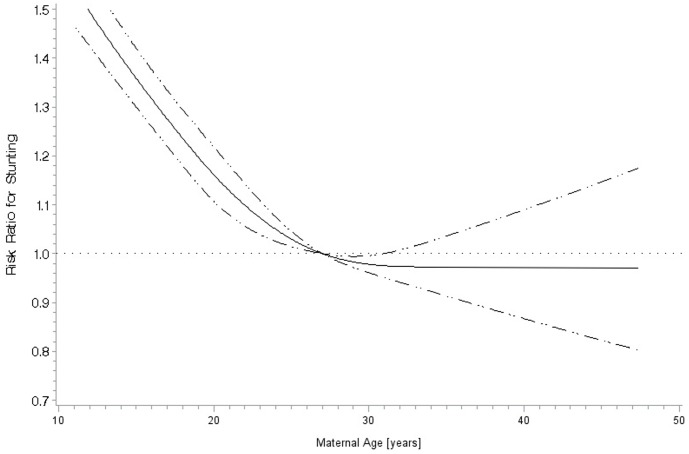
Non-linear adjusteda relationship of maternal age with stunting for firstborn childrenb.
aAdjusted for same factors as Table 1 Caption. b 27 years is the reference group (p-value for non-linear relationship: <0.001).